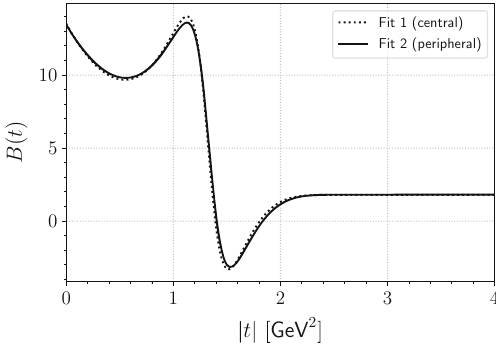
Fig. 2 Elastic hadronic phases ζ N ( s , t ) for central and peripheral pic- tures of elastic pp scattering (Fits 1 and 2) at energy of 52.8 GeV